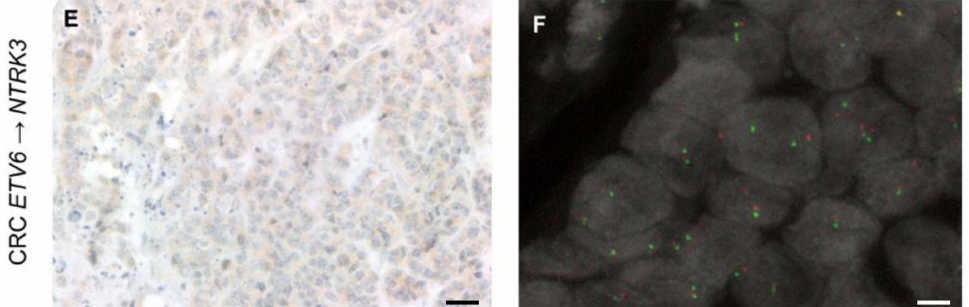
Figure 5. Representative IHC and FISH images of the cases identified as harbouring an NTRK gene fusion (scale bars—IHC images: 50 µ m; scale bars—FISH images = 5 µ m). ( A , B ) The FISH test for the CRC harbouring the intrachromosomal TPM3 → NTRK1 rearrangement, as identified by NGS, and displaying strong and diffuse panTRK expression by IHC was suboptimal in terms of quality. Following multiple attempts in all of the available tumour blocks, in scattered tumour cells showing red and green signals, the NTRK1 probes appeared slightly split-apart. This FISH test would have led to an indeterminate result in a diagnostic setting. ( C , D ) In the LAC sample harbouring the ETV6 → NTRK3 fusion, occasional (<10%) nuclei with signals pertaining to NTRK3 probes that were slightly split-apart could be identified. It should be acknowledged that according to standard FISH scoring criteria, (i) the distance between signals may be debatable and (ii) the test would be considered negative, given that the positive nuclei do not reach the 15% cut-off used in the diagnostic setting. ( E , F ) The CRC sample harbouring the ETV6 → NTRK3 fusion showed split-apart NTRK3 signals in about 17% of the tumour cell population (here illustrated). This FISH test meets the criteria for the identification of a genetic rearrangement involving NTRK3